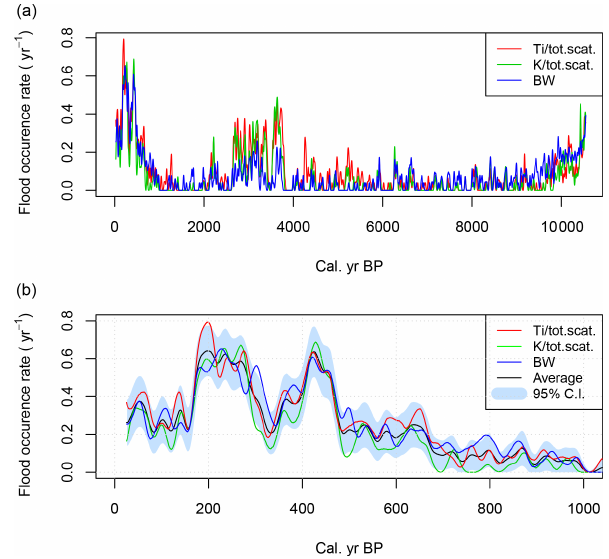
Figure 13. In (a) , average flood rate per year calculated in a 50- year moving window during the Holocene. In (b) , the most recent 1000 years are shown only. Panel (b) also includes a 95% con- fidence interval for the average flood rates. The flood rates were identified by detecting local peaks in Ti / total scatter , K / total scatter , and BW